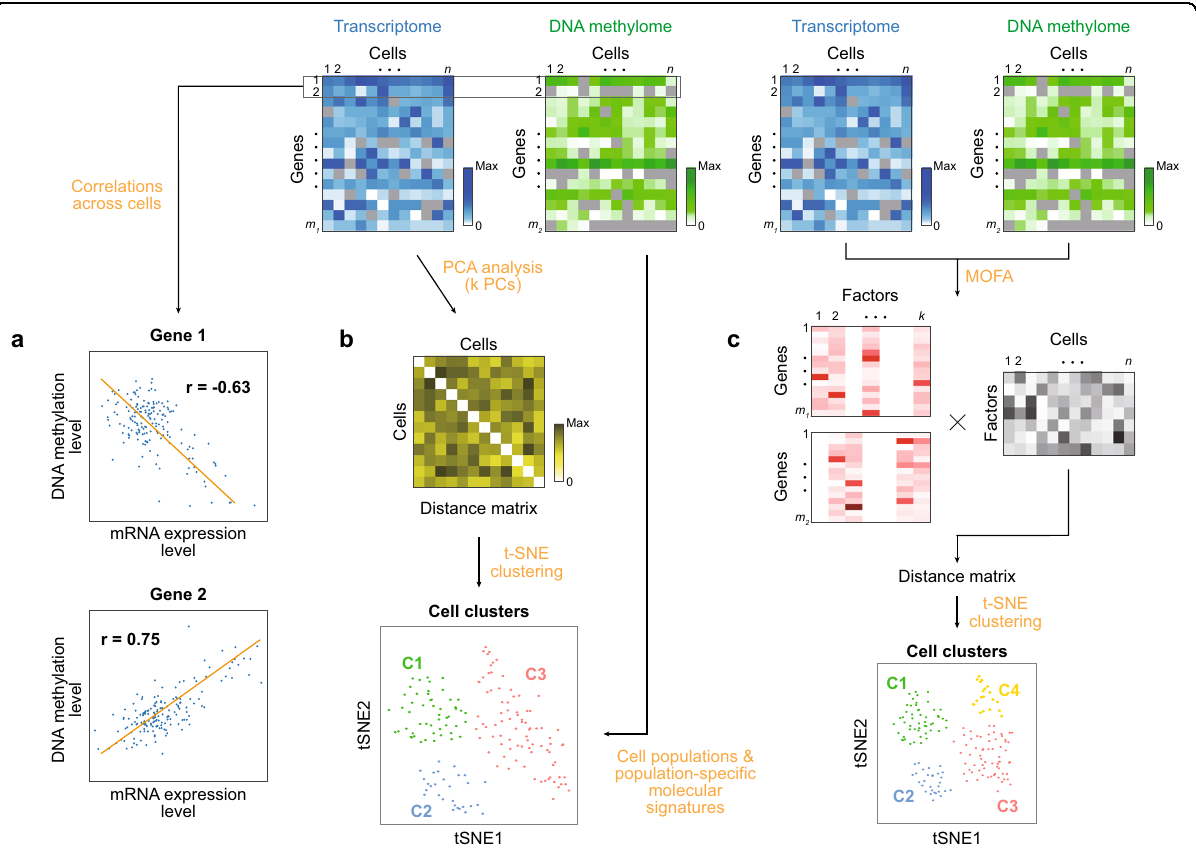
Fig. 5 Strategies for the integrative analysis of single-cell multiomics data. Blue and green heat maps represent the data matrixes for the transcriptome and DNA methylome, respectively. The symbols n , m 1 , and m 2 denote the numbers of cells ( n ) and genes with the levels of mRNA ( m 1 ) and DNA methylation ( m 2 ). Colors in the heat maps represent the levels of mRNA and DNA methylation (see color bars; Max, the maximum level). a Correlation analysis between mRNA and DNA methylation levels. Scatter plots show mRNA and DNA methylation levels for genes 1 (top) and 2 (bottom). Line, regression line; r , Pearson correlation. Negative and positive correlations are shown for genes 1 and 2, respectively. b Analysis of scRNA-seq data followed by the integration of scBS-seq data. Principal component analysis (PCA) is fi rst applied to scRNA-seq data to obtain score values for k PCs, the pairwise Euclidean distances of cells are computed using the score values for k PCs to generate a distance matrix, t-stochastic neighbor embedding (t-SNE) clustering is applied to the distance matrix to identify cell populations, and scBS-seq data are then integrated into these cell populations as described in the text. C1-3, cell populations 1-3, respectively. c Integrative analysis of scRNA-seq and scBS-seq data to generate the overall single-cell map. The analytical scheme of MOFA is shown. Two-way matrix decomposition is performed for scRNA-seq and scBS-seq data using k factors, resulting in weight matrixes ( m 1 × k for scRNA-seq data and m 2 × k for scBS-seq data) and a factor loading matrix ( k × n for n cells). Factor loading values are used to compute a distance matrix that is then used for t-SNE clustering. The t-SNE plot shows cell populations 1-4 (C1-4) identi fi ed collectively by scRNA-seq and scBS-seq